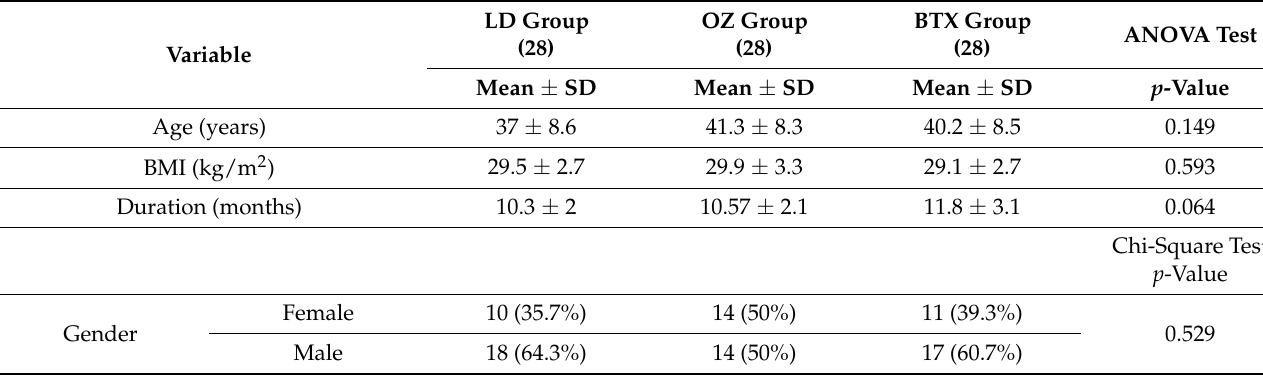
Table 1. Demographic data of the three studied